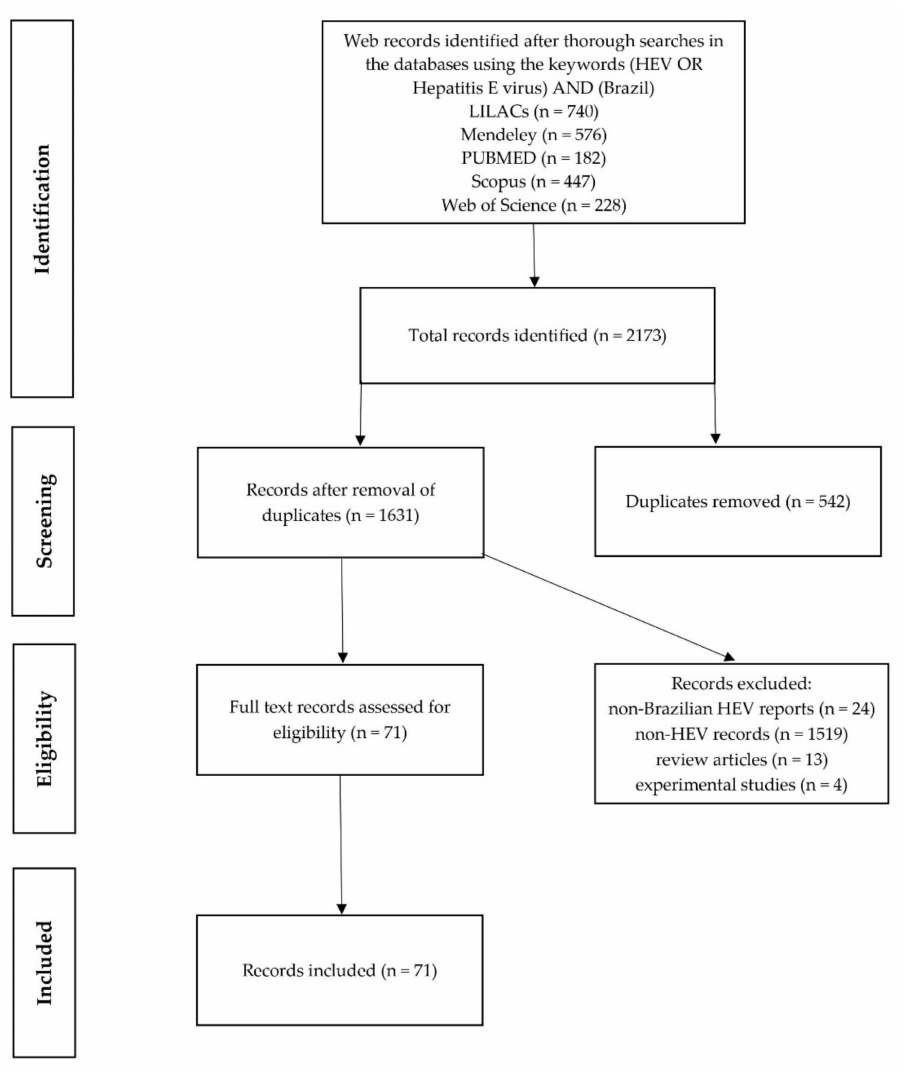
Figure 1. PRISMA Flow diagram showing the steps of the record selection procedure and reporting the strategies of inclusion/exclusion (explaining their